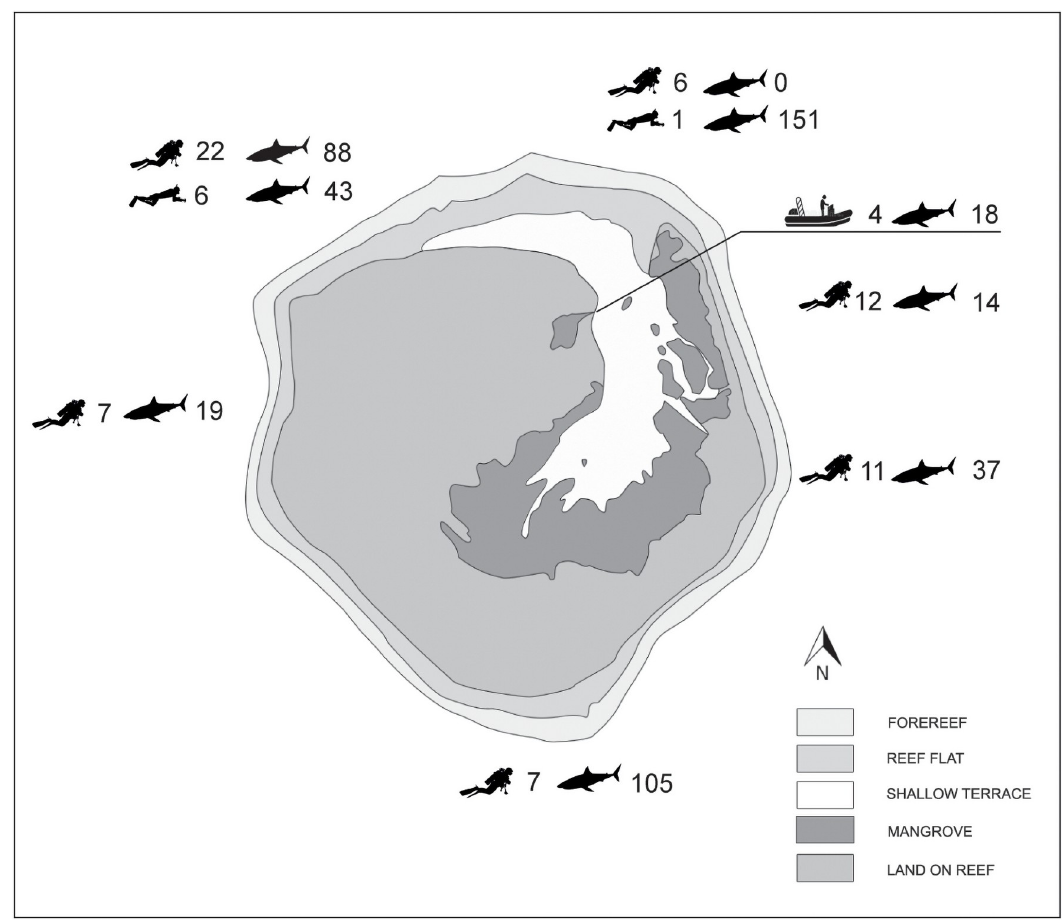
Fig 2. Number of field observations while diving, snorkeling, or from a dinghy in the lagoon, with corresponding number of sharks observed. Basemap adapted from https://eol.jsc.nasa.gov/SearchPhotos/photo.pl?mission=ISS005&roll=E&frame=9408 using Adobe Illustrator; Shapefile for diver retrieved from https://fr.depositphotos.com/1807037/stock-illustration-scuba-diving- silhouettes.html; for shark from https://pixabay.com/fr/vectors/animal-requin-silhouette-3364833/; and for boat from https://fr. dreamstime.com/bateau-icoˆne-moteur-e´le´ment-d-transport-l-eau-des-applis-mobiles-concept-web-de´taille´-peut- ê tre-utilise´- image131545556.